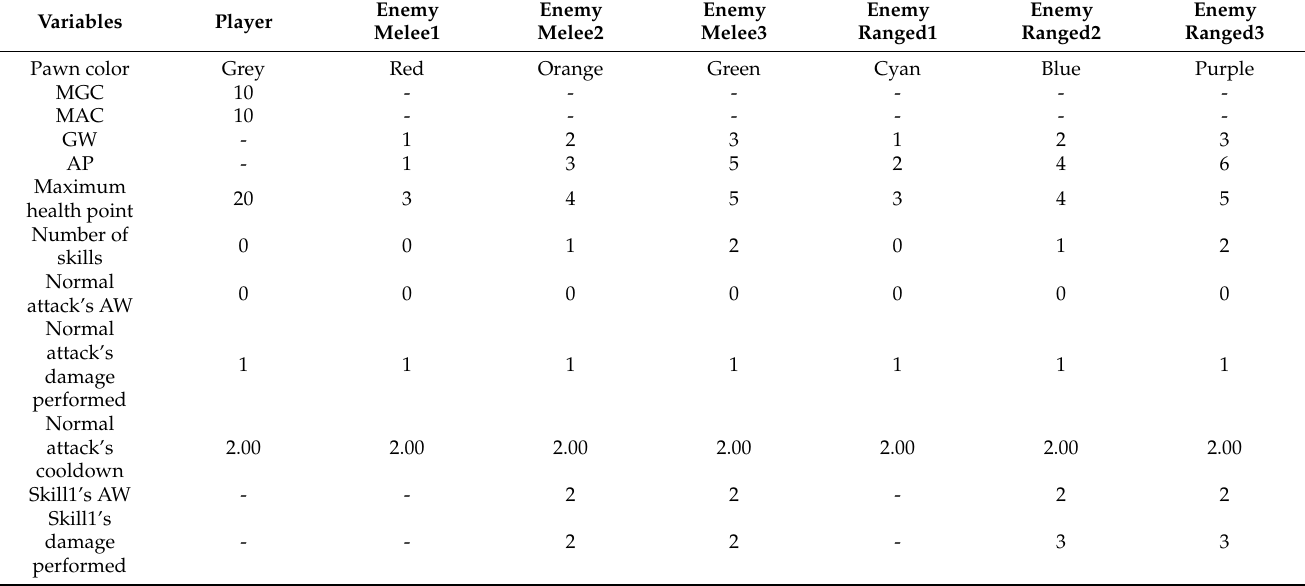
Table 3. Essential variable values in the player class and each enemy class.